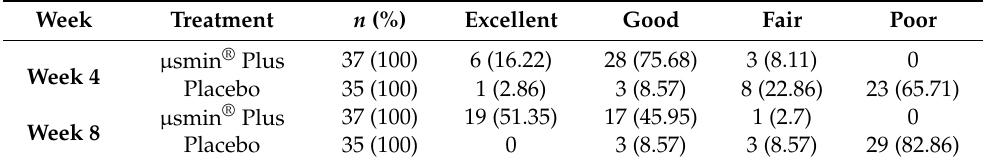
Table 2. Investigator Global Assessment of the Efficacy (IGAE) after 4 weeks and 8 weeks of treatment. Week